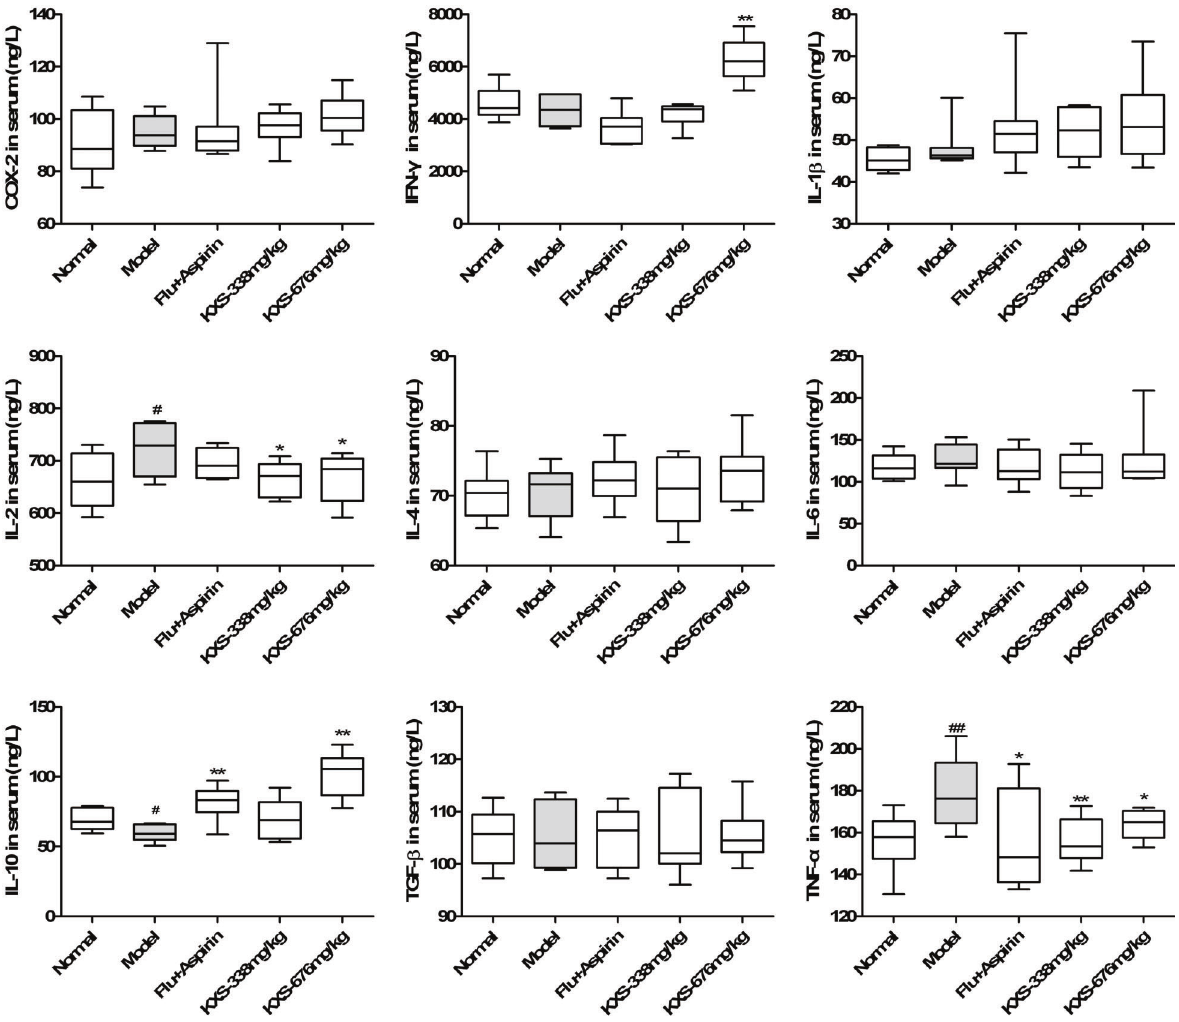
Figure 2. Effects of Kai-Xin-San (KXS) on cytokines in serum in fl uoxetine-resistant depression (FRD) rats exposed to chronic and unpredictable mild stress model and randomly divided into four groups: FRD model control (Model), oral fl uoxetine and aspirin (Flu + Aspirin), oral KXS at a dose of 338 mg/kg, and 676 mg/kg. Data are reported as means ± SD, n=12. # P o 0.05, ## P o 0.01 compared to untreated Normal group. *P o 0.05, **P o 0.01 compared to Model